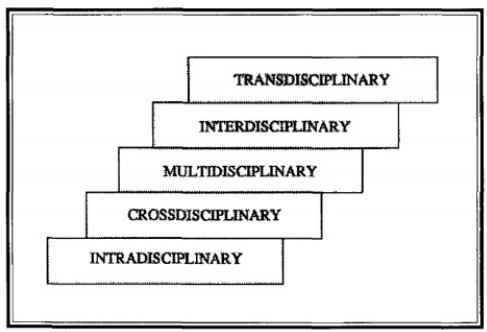
Figure 1. Stember’s Disciplinary Typology for enterprises within and across disciplines